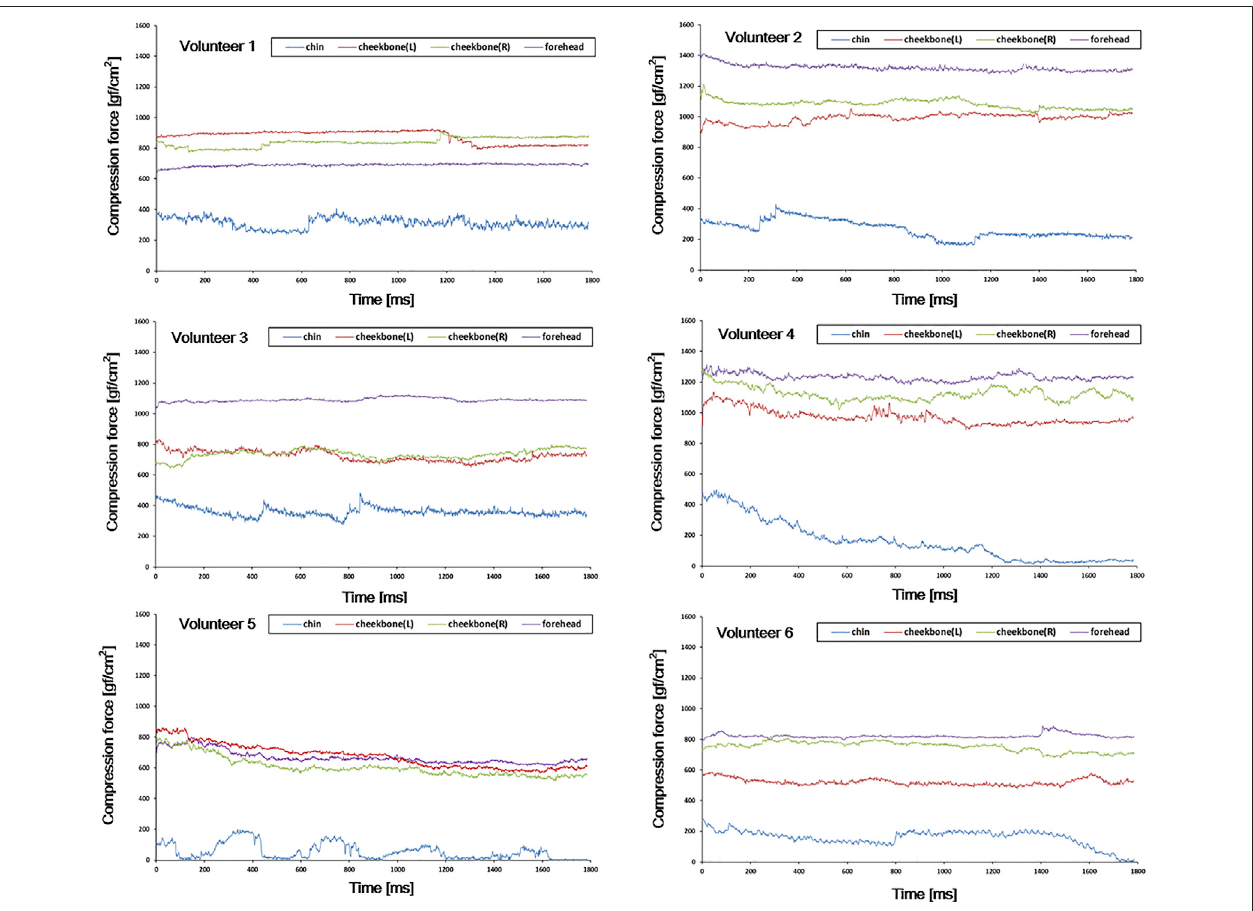
FIGURE7| Compressionforcevariationofeachvolunteerinthe fi rst3-minsession.Variouscompressionforcevariationswereobserveddependingonthelocation of the sensor (forehead, both cheekbones, and chin) and volunteers.